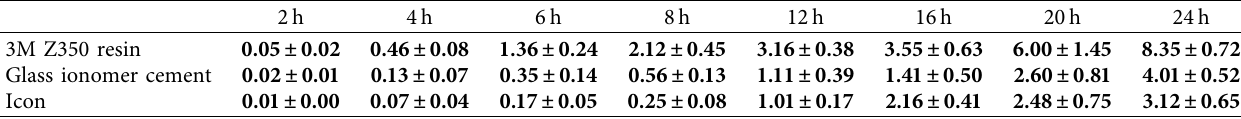
Table 3: Streptococcus mutans group (plate colony counting).